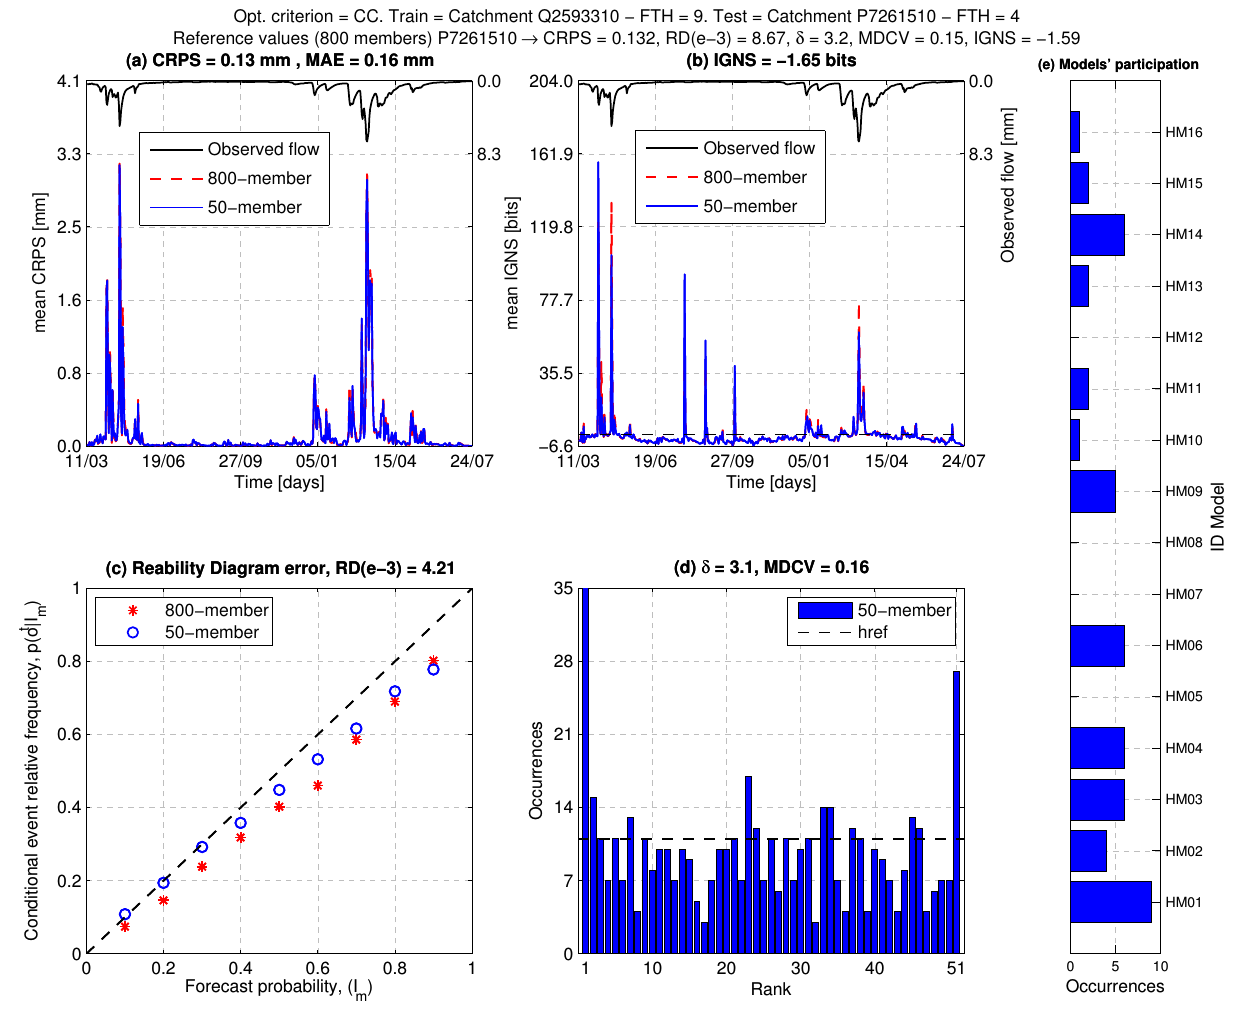
Fig. 5. Comparison between the initial ensemble (800 members) and the ensemble selected (50 members) for a lead time of 9 days. (a) Figure above: observed flow; figure below: CRPS (x-axis formatted as: day/month). Note the correspondence between higher observed flows and higher CRPS. (b) Figure above: observed flow; figure below: IGNS (x-axis formatted as: day/month). (c) Reliability diagram error (MSE based on vertical distances between the points). (d) Rank histogram for the 50 hydrological members selected. The horizontal dashed line indicates the frequency ( N/d +1) attained by a uniform distribution. (e) Occurrences of the employed models in the final solution of 50 hydrological